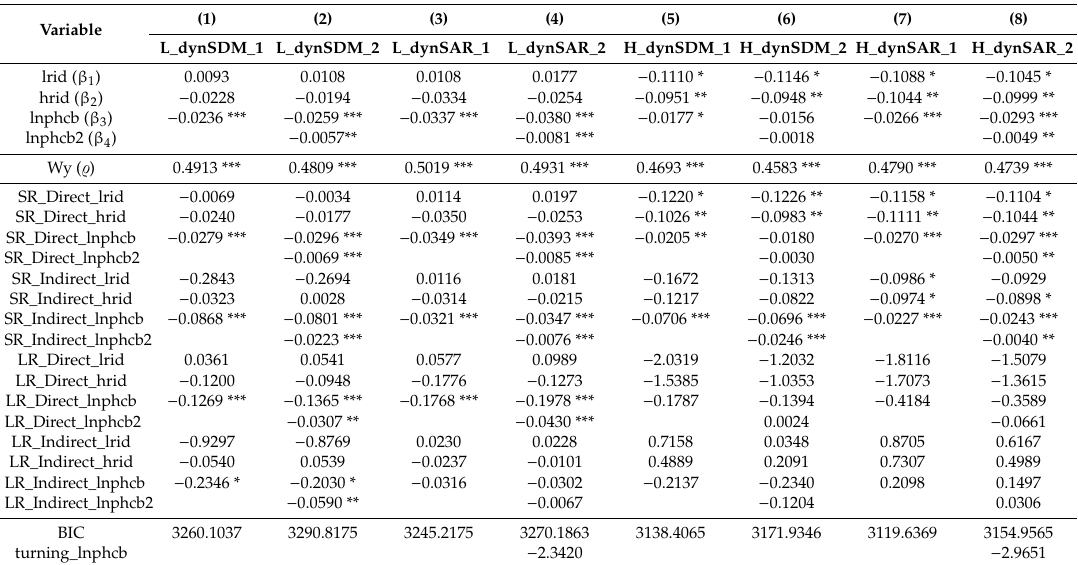
Table 4. Benchmark analysis of heterogeneous food price risk